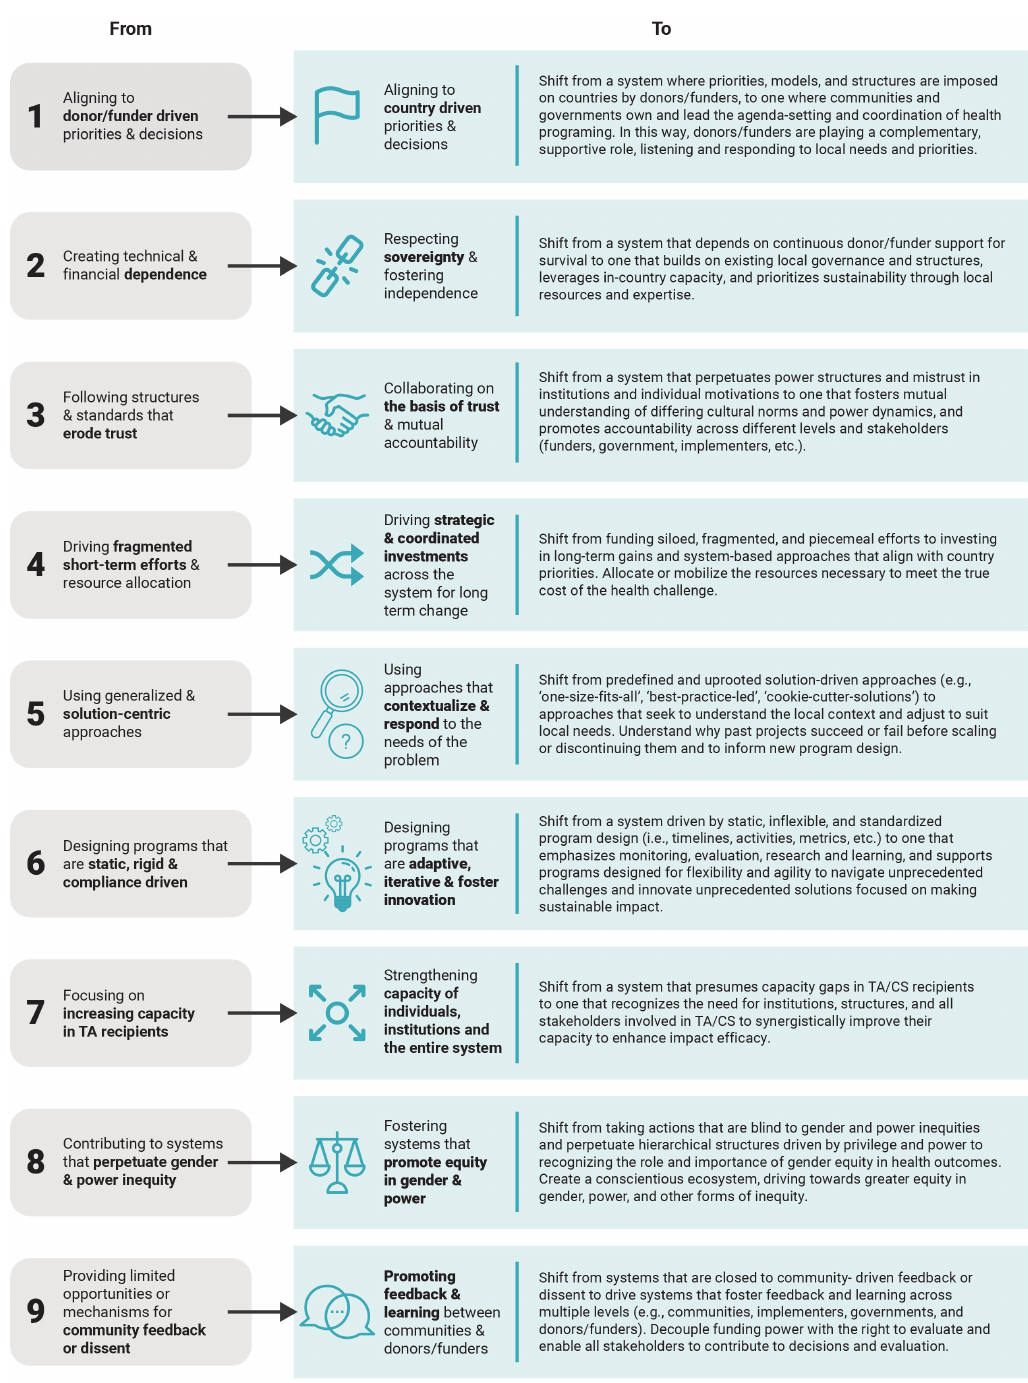
Figure 1. Critical Shifts for Capacity